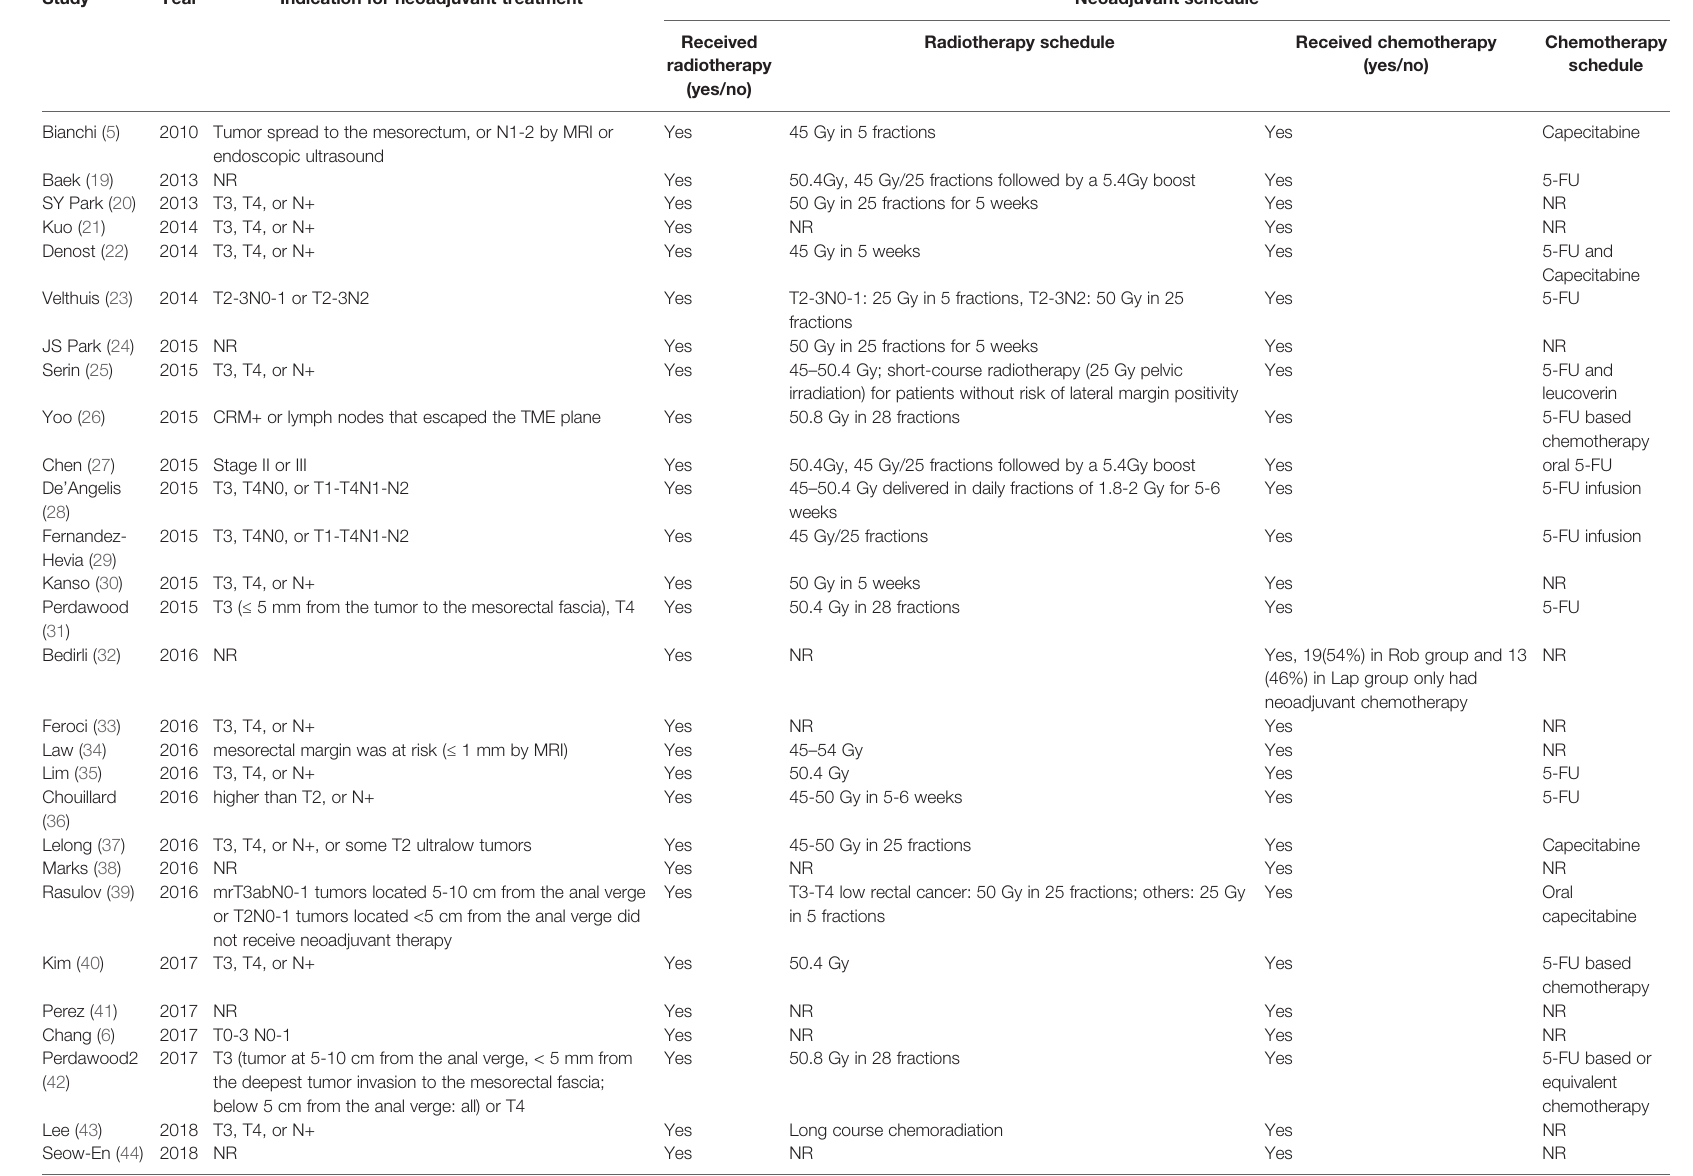
TABLE 3 | Neoadjuvant treatment schedules in included